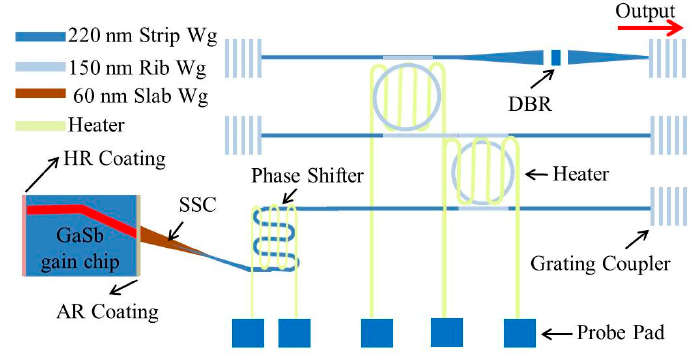
Figure 10. Schematic of a GaSb/silicon hybrid external cavity laser.